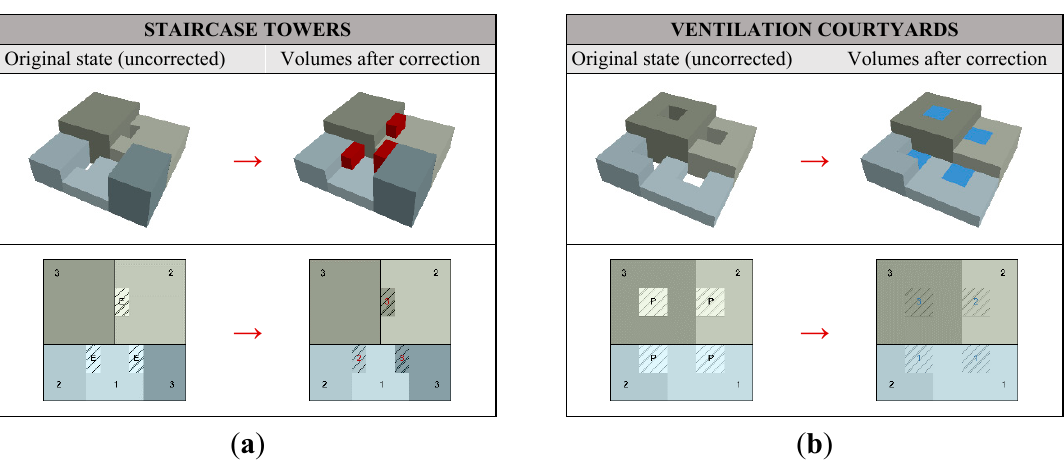
Figure 2. Correction of staircase towers ( a ) and ventilation courtyards ( b